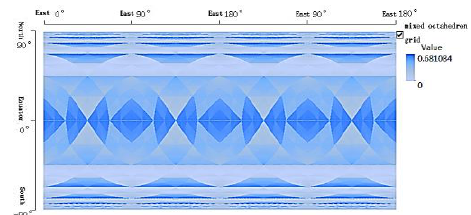
Figure 10. The planar distribution of mean square deviation of major-minor of octahedron grid divided by mixed method Figure 5. The planar distribution of octahedron grid divided by obtained by recursively bisecting the longitude-latitude arc lines on the surface of the globe starting with the octahedron are worse than surface of the globe starting with the icosahedron are better than others.